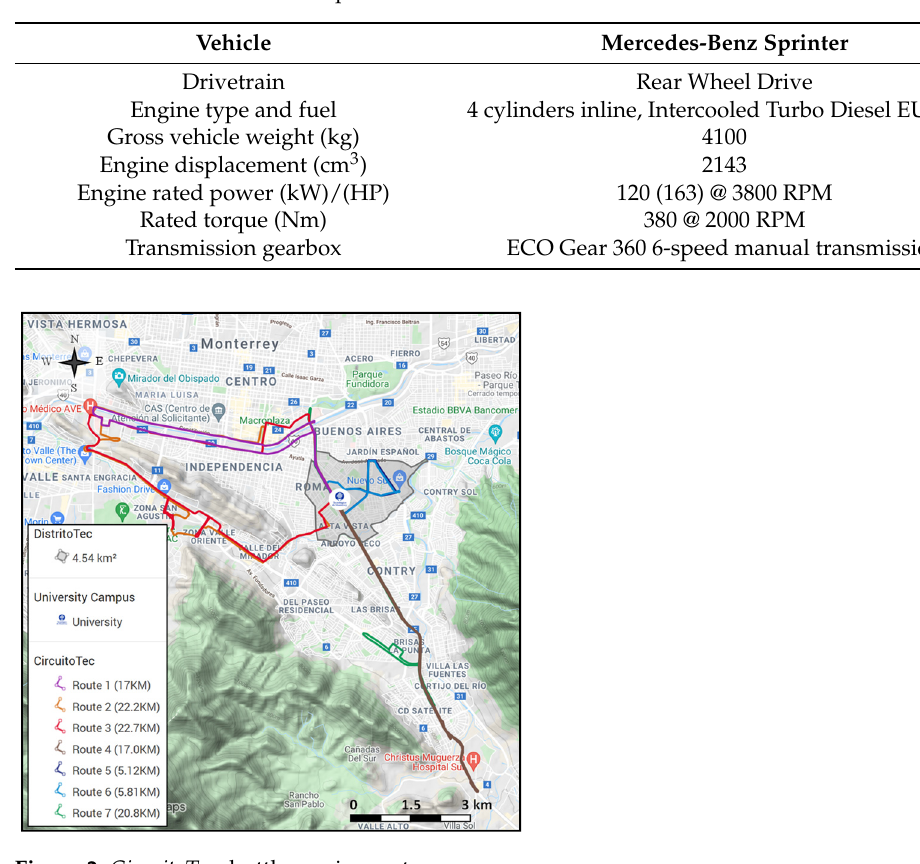
Table 1. Shuttle service vehicle specifications.